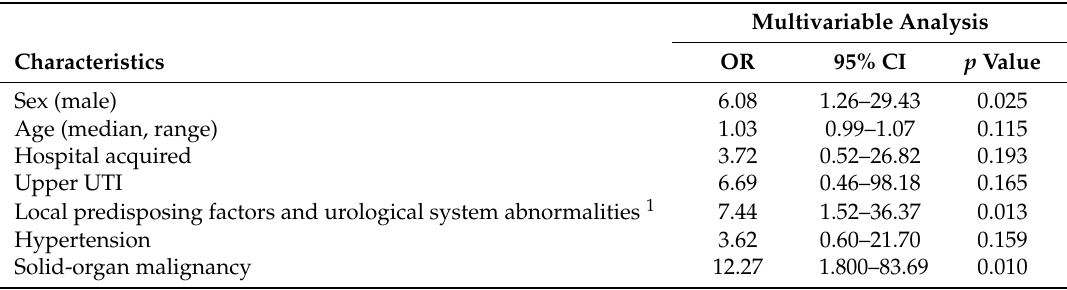
Table 2. Results of a multivariable analysis of the clinical characteristics associated with S. lugdunensis and S. saprophyticus urinary tract infection.